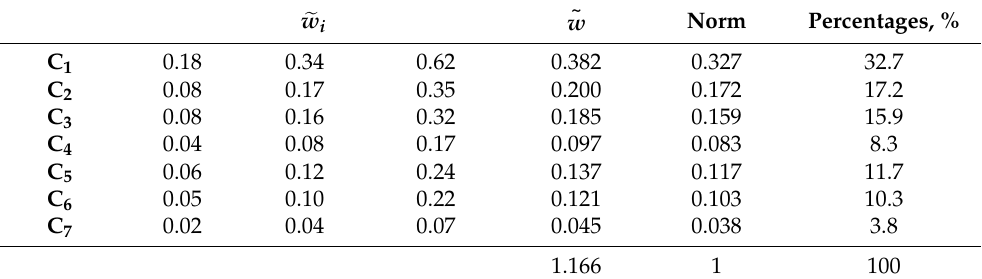
Table 8. Defuzzified and normalized weights obtained for key geomechanical parameters of the Ridder–Sokolny